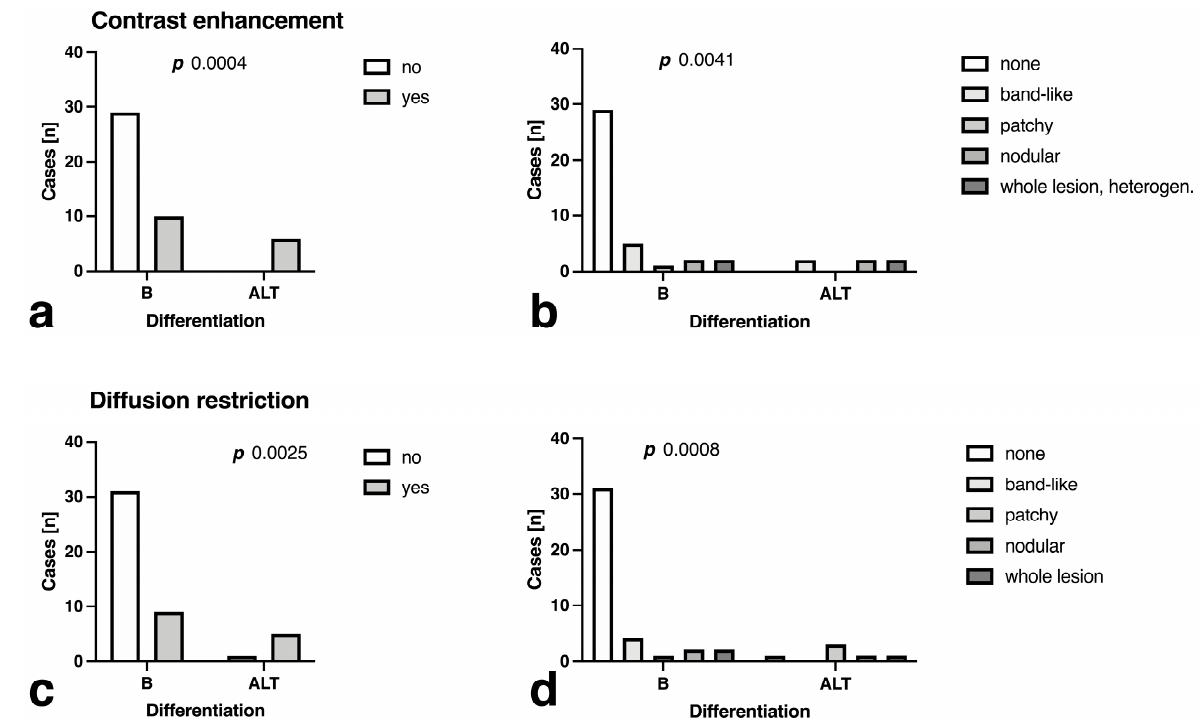
Figure 5. Comparison of ( a ) presence of contrast-enhancement, ( b ) contrast-enhancement patterns and ( c ) ADC alterations, defined as areas of discernible low ADC signal, ( d ) ADC pattern distribution in benign (B) tumors and atypical) lipomatous tumors (ALT.